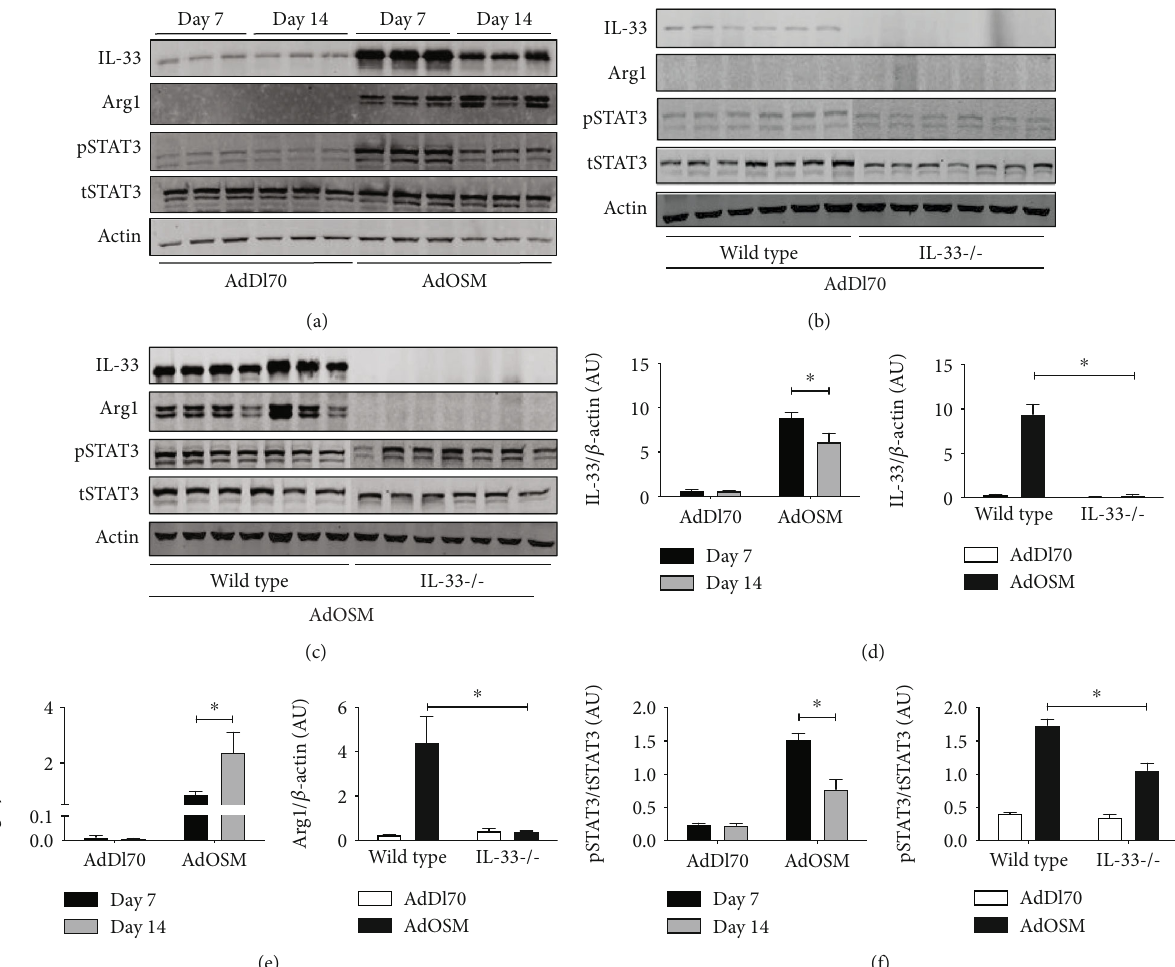
Figure 1: AdOSM-induced upregulation of arginase-1 (Arg1) protein expression in the mouse lung is IL-33-dependent. C57Bl/6 mice were endotracheally administered AdDl70 (control) or AdOSM and whole lung cell lysates analyzed for the expression of IL-33, phospho- STAT3/total STAT3 (pSTAT3/tSTAT3), and arginase-1 (Arg1) after 7 and 14 days by Western blotting. (a) IL-33, Arg1, phospho-STAT3 (pSTAT3), and beta-actin (Actin) expression in C57Bl/6 wild-type mice. (b, c) IL-33, pSTAT3/tSTAT3, Arg1, and beta-actin (Actin) expression in C57Bl/6 wild-type or IL-33-/- (IL-33-/-) mice at day 7. (d – f) Densitometry analysis of IL-33 and Arg1 signal relative to beta- actin levels or pSTAT3 relative to total STAT3 (tSTAT3), in C57Bl/6 mouse lung data shown in (a) or (b/c), respectively. AU: arbitrary units; N : 3 mice/group in (a) and 5-7 mice/group in (b/c). ∗ p < : 01